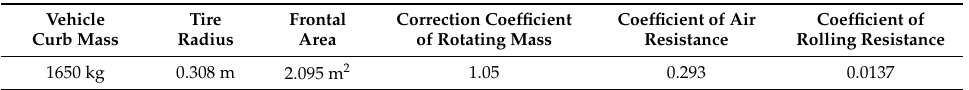
Table 2. Vehicle parameters of four-wheel drive HEV.